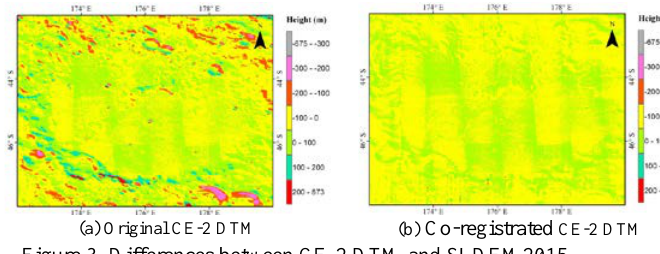
Figure 3. Differences between CE-2 DTM and SLDEM2015 Table 1. Height difference between SLDEM2015 and CE-2 DTMs (original DTM and co-registrated